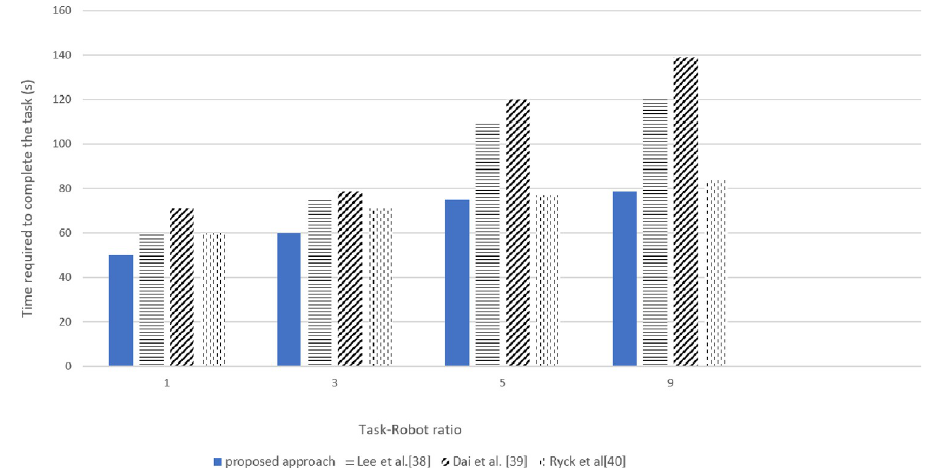
Fig 11. Simulated results for total completion time for various tasks-robot ratios.